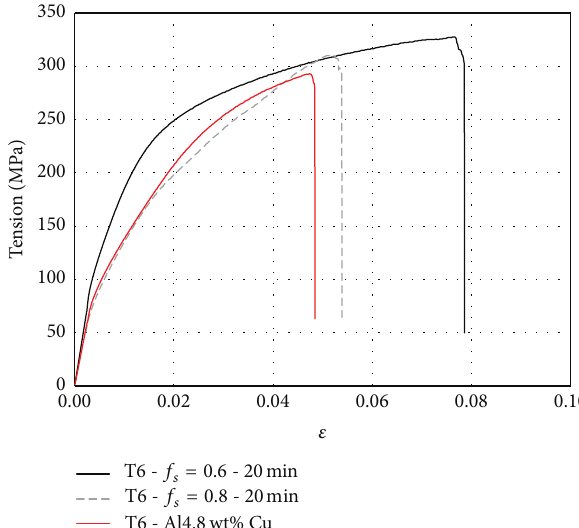
Figure 8: Some typical tensile curves obtained from different thixoforged samples submitted to the T6 heat treatment (solutionizing during 24 h at 525 ∘ C and aging during 3h at 190 ∘